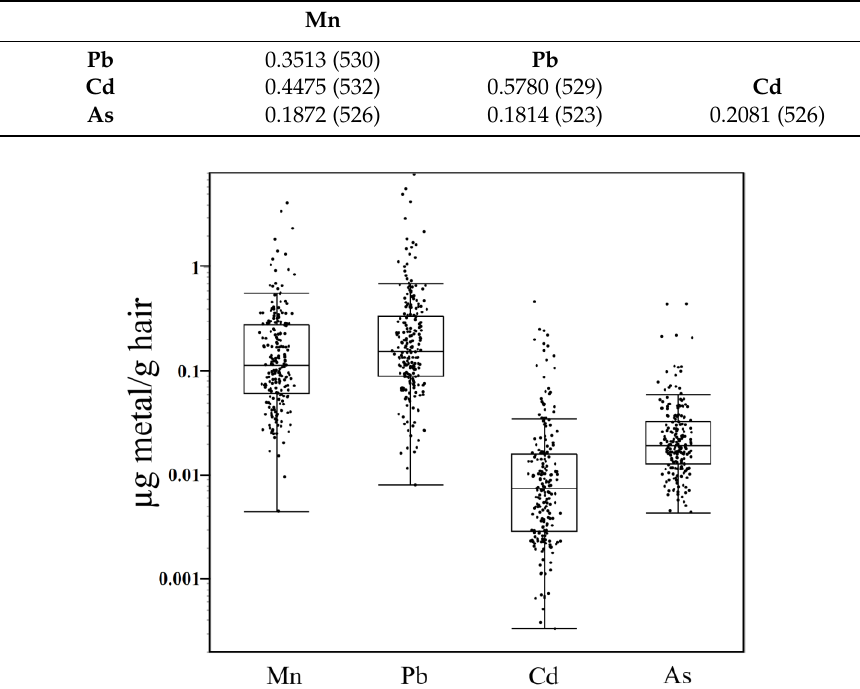
Figure 1. Hair metal concentrations (µg/g, note log scale) in the proximal 2 cm hair segment for male ( n = 53) and female ( n = 169) subjects. The horizontal line within the box represents the median, while the upper and lower margins of the boxes represent the 75th and 25th percentiles; whiskers are drawn to the furthest data point within 1.5-times the interquartile range. N = 214 – 222; hair metal values below the limit of detection are excluded.